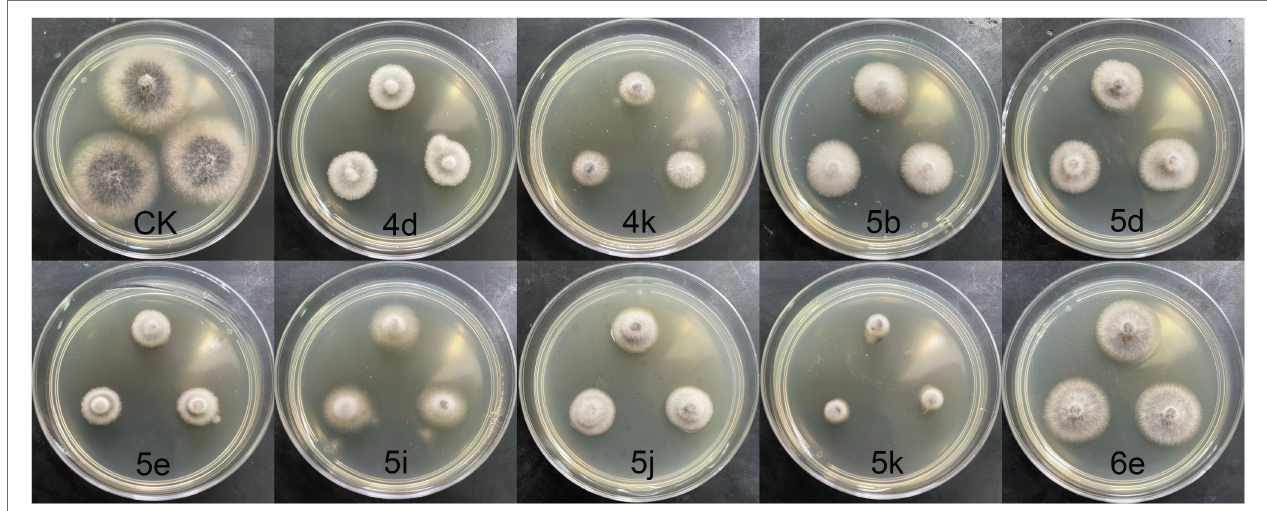
FIGURE 1 | Antifungal activities of active compounds against Exserohilum turcicum .